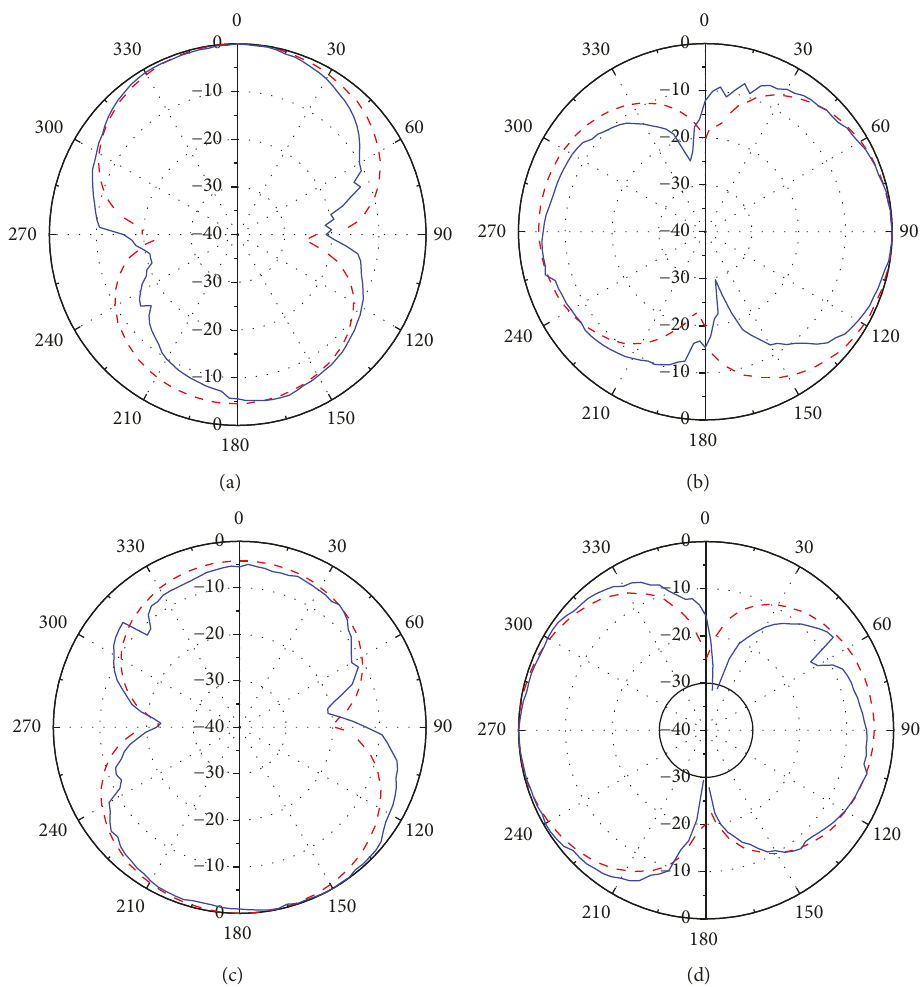
Figure 12: Beam steered radiation patterns for each direction with the reactive loads of a diode (solid line) and a chip capacitor (dashed lines): (a) +y-direction; (b) +x-direction; (c) -y-direction; (d)